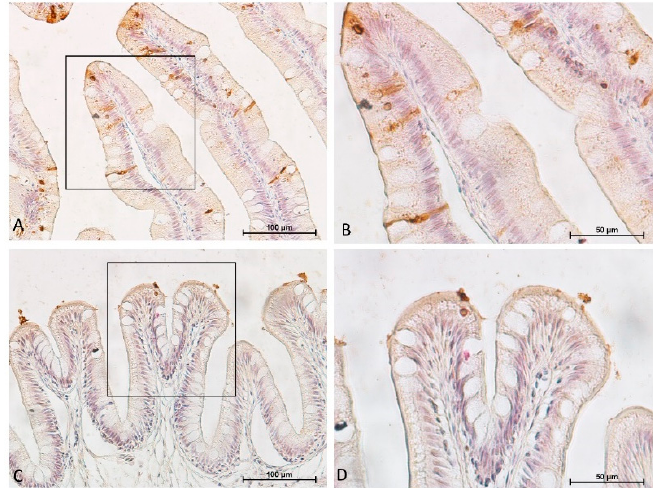
Figure 17. Representative figure of cells undergoing apoptosis showing numerous, both round and slender apoptotic cells in the basal part of the complex folds ( A , B ) and only a few round apoptotic cells in the apical part of the complex folds ( C , D ).